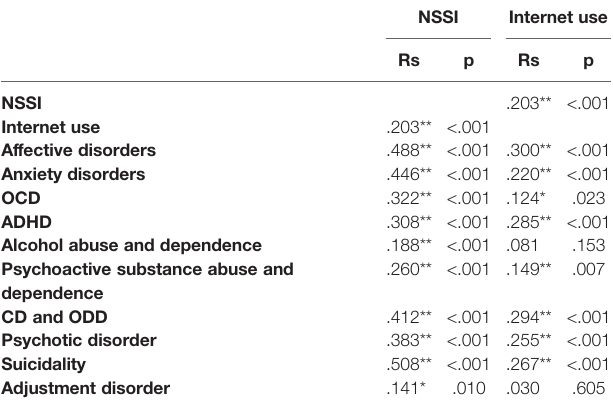
TABLE 4 | Correlation between NSSI, internet use, and M.I.N.I Kid